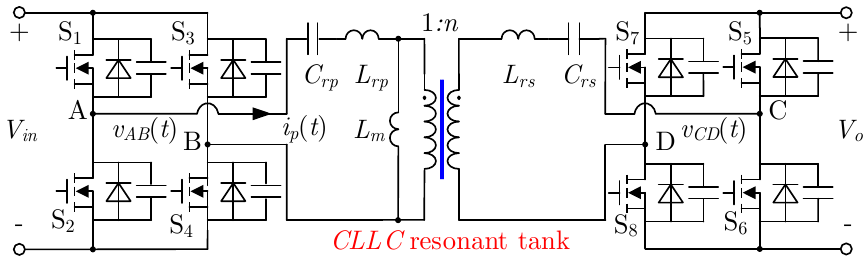
Figure 1. The CLLC resonant converter.